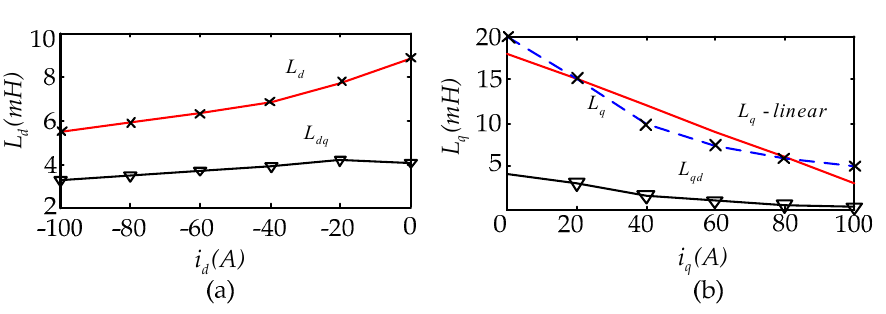
Figure 4. Inductances as function of its own axis current. ( a ) d -axis inductance; ( b ) q -axis inductance.